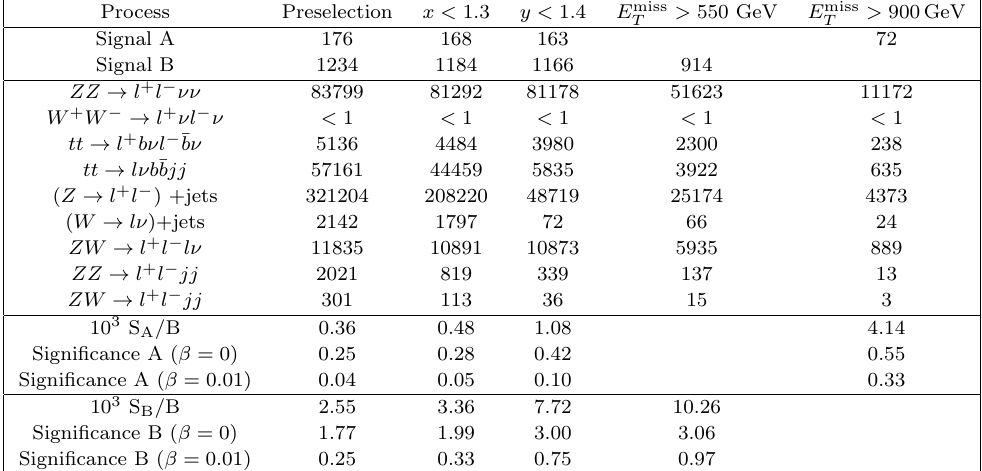
Table 1 . Cut (cid:13)ow for the backgrounds and for signal points with with masses 1100 GeV (A) and 400 GeV (B) and nominal charged-neutral splitting (optimized for zero background systematics in each case). The numbers of events quoted correspond to a total integrated luminosity of 30 ab (cid:0) 1 at a 100 TeV center-of-mass energy. The signi(cid:12)cance is computed assuming a) no systematic errors and b) 1 % systematic